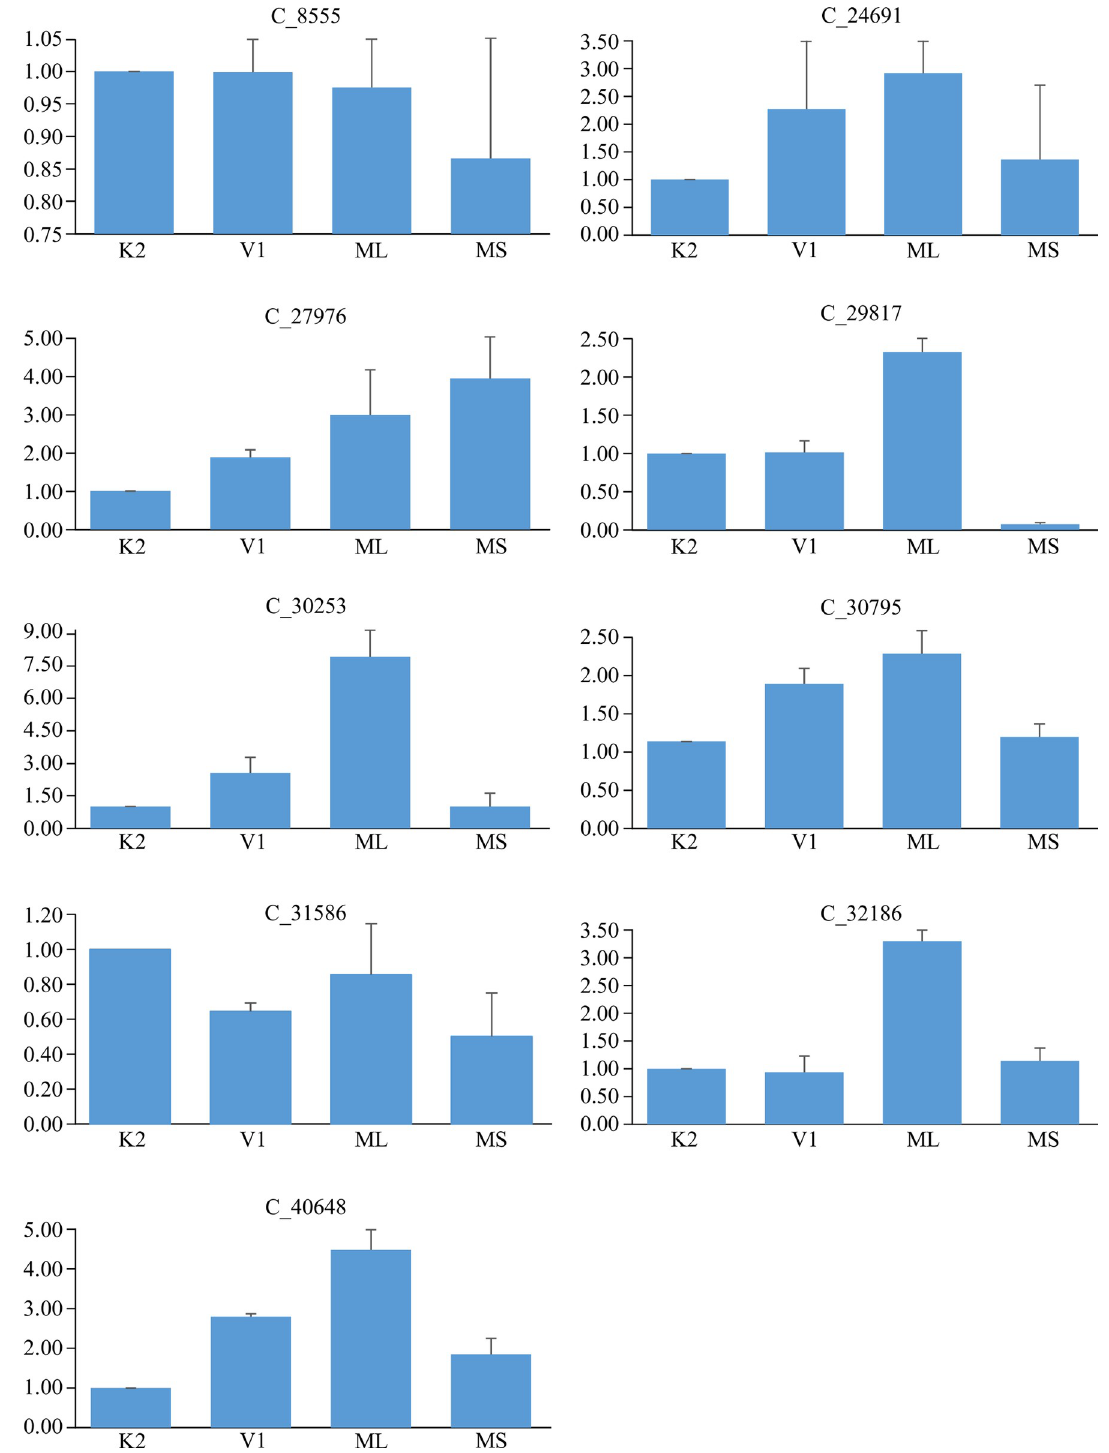
Fig 3. Bar graphs showing the relative expression pattern obtained in leaf samples of five genotypes studies. δδ Ct method was applied to calculate the relative fold changes. X axis represents the fold change and Y axis represents the stages. Error bars represent the standard errors. Person correlation coefficient was also calculated for data obtained from RNA-seq and qPCR (See text for details).